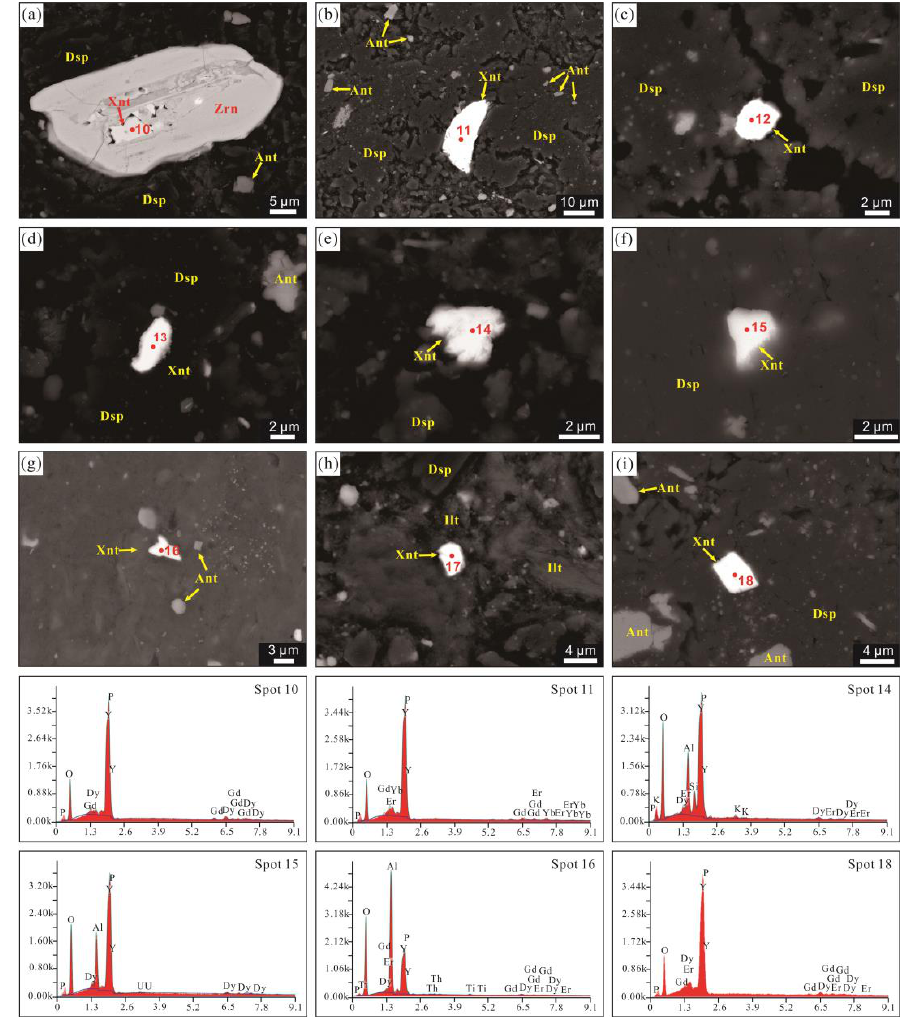
Figure 10. SEM backscattered electron (BSE) images of xenotime and representative EDS spectra. ( a ) Detrital xenotime showing the xenotime crystal is surrounded by zircon crystal; ( b – d ) detrital xe-